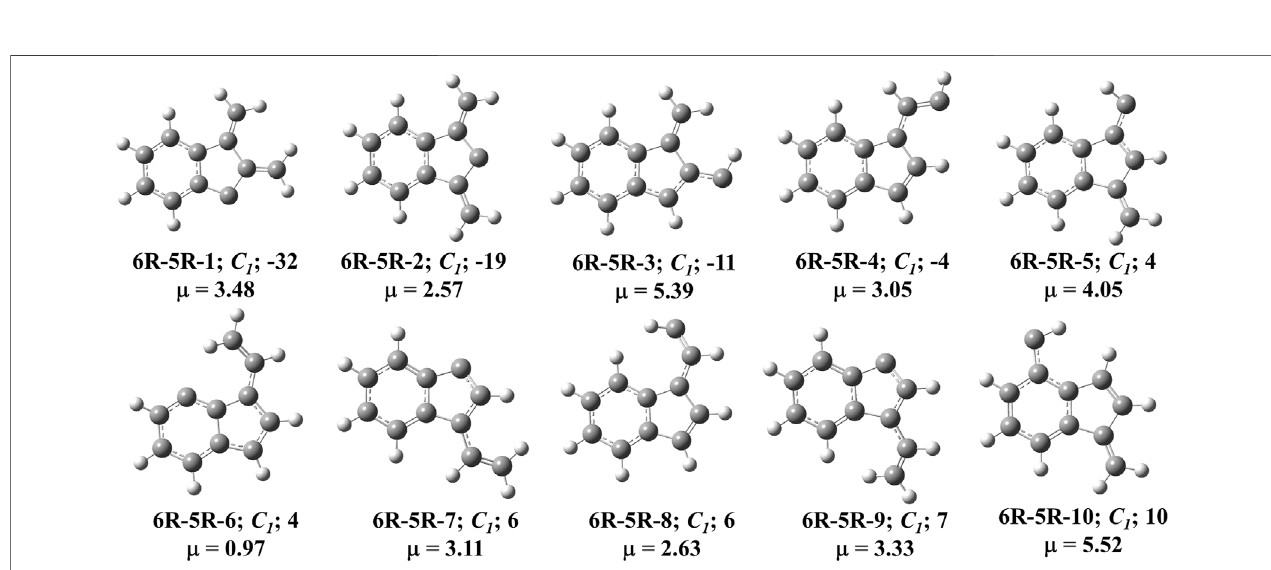
FIGURE 6 | First ten low-lying C 11 H 8 carbenes/cyclic allenes isomers of (6R-5R) group. ZPVE-corrected relative energies (in kJ mol − 1 ), absolute dipole moment values (in Debye) are calculated at the B3LYP/6-311 + G (d,p) level of theory. Experimentally detected isomers are marked with an asterisk symbol.